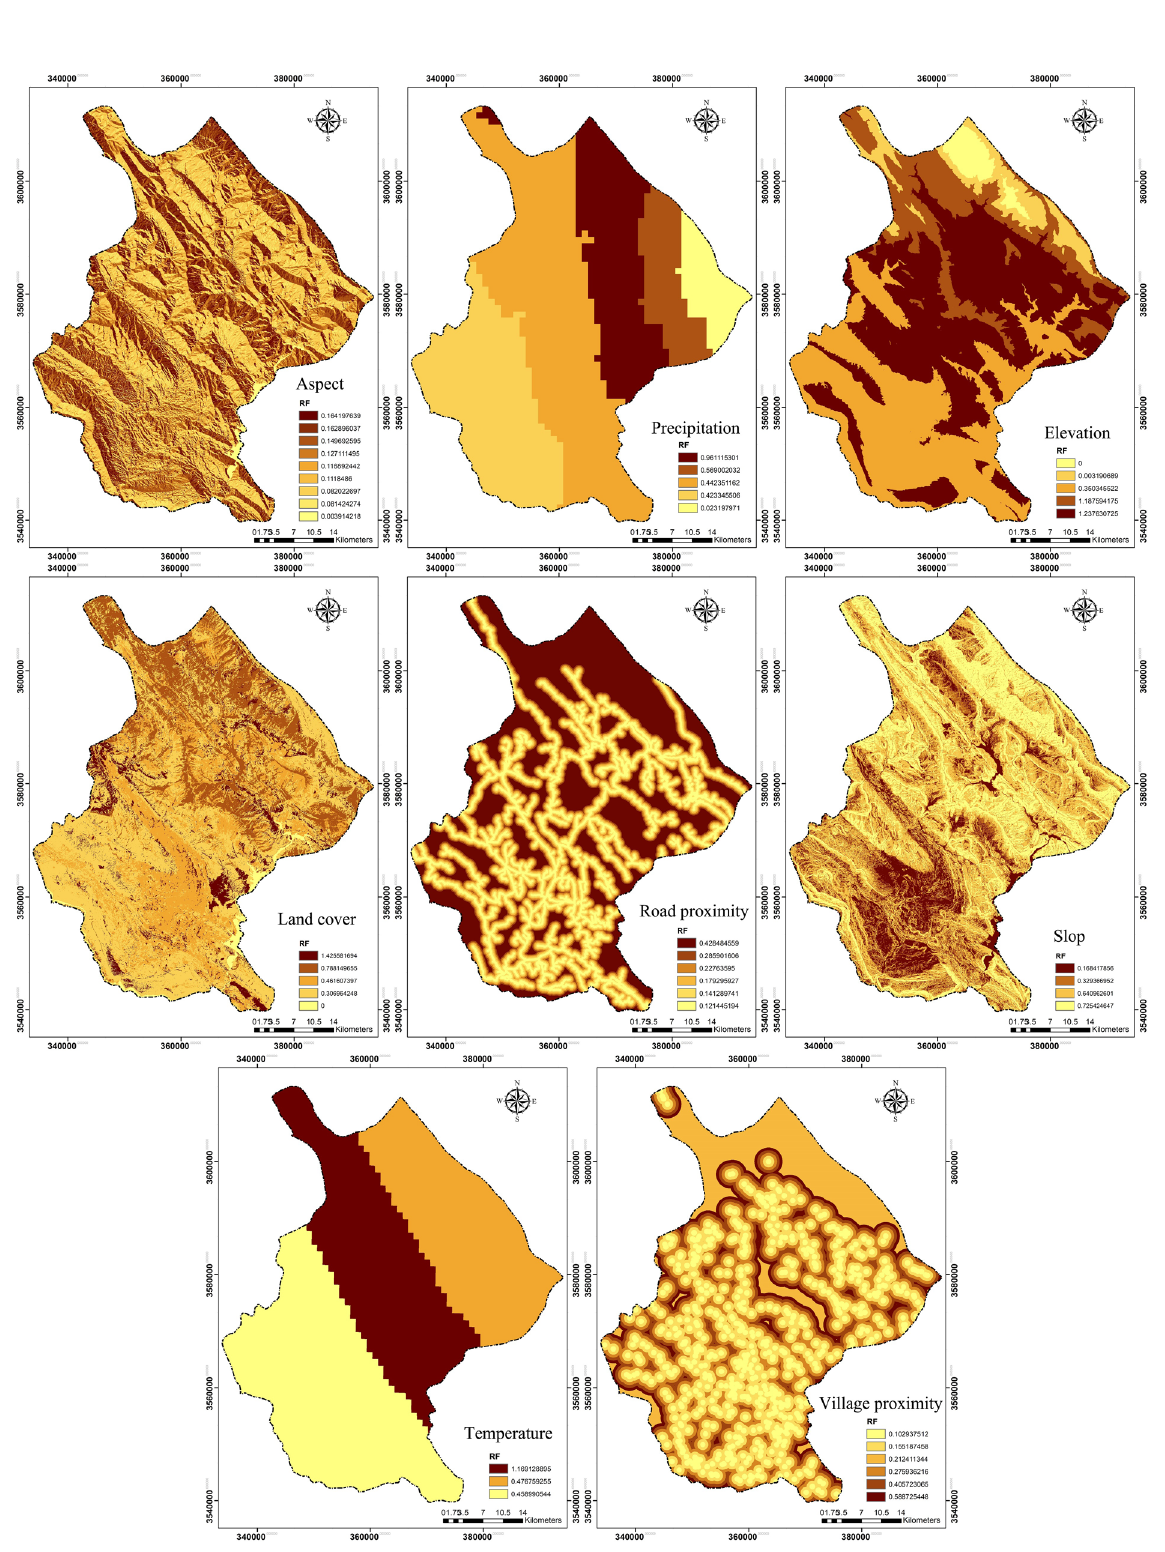
Figure 7. Fire hazard map obtained by NBR index and frequency ratio model: A) Criteria layersreclassified by related RF val- ues; B) fire hazard map produced by NBR index and frequency ratio